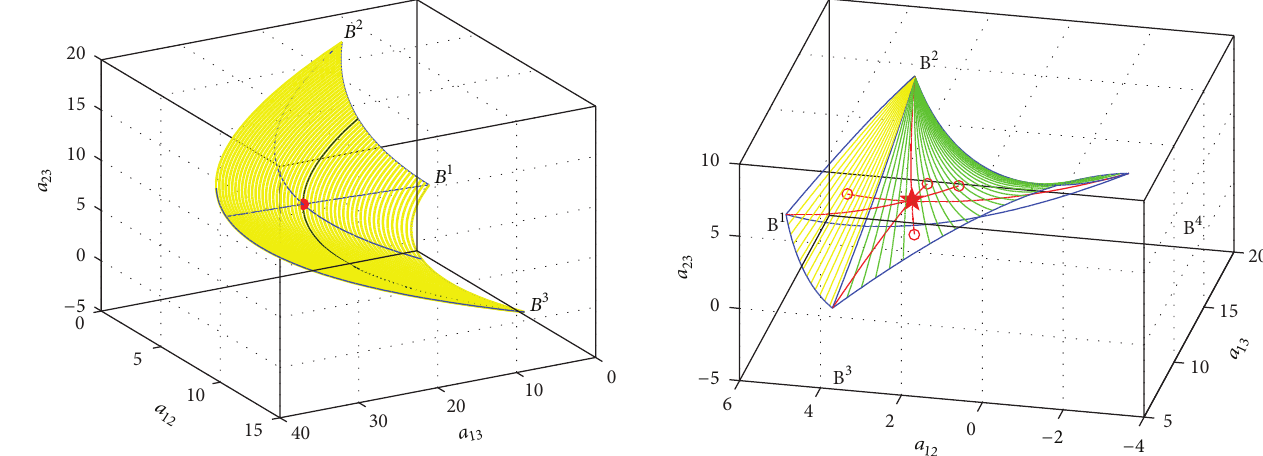
Figure 6: The Riemannian mean of four